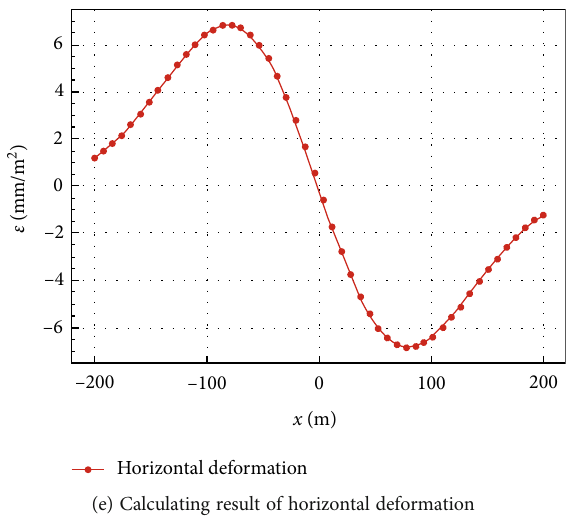
Figure 8: Calculation curve diagram of case (a).